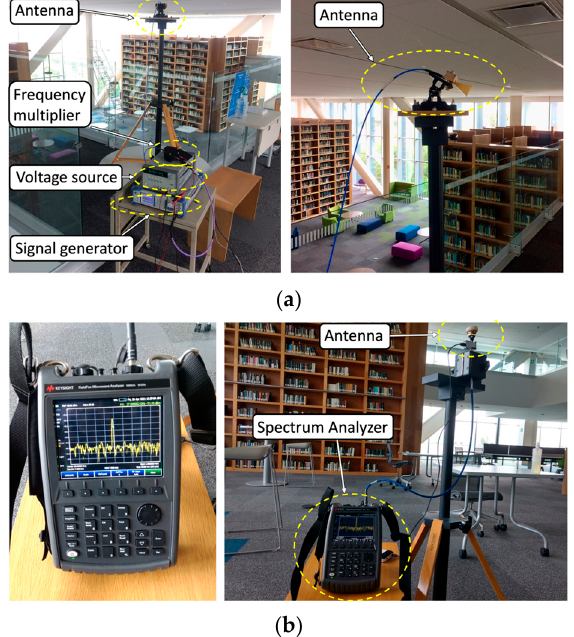
Figure 6. Measurement setup at 28 GHz frequency on the first and second floors of the library: ( a ) transmitter and ( b ) receiver.